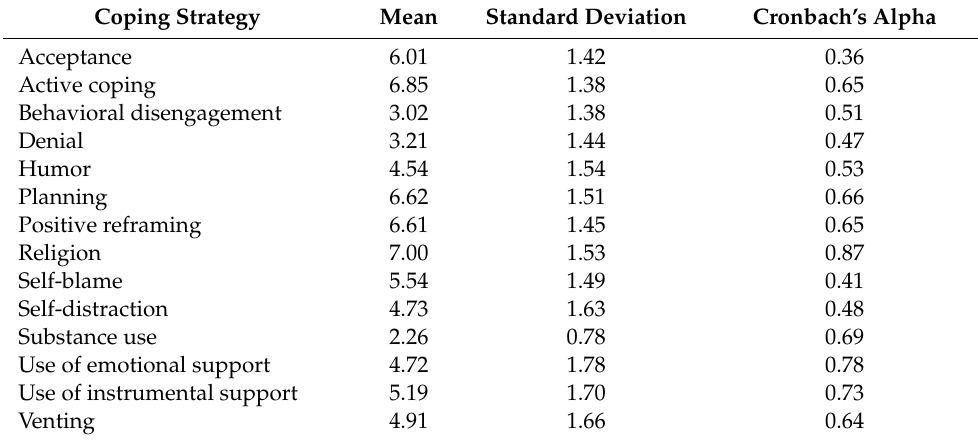
Table 1. Descriptive statistics of the Brief COPE